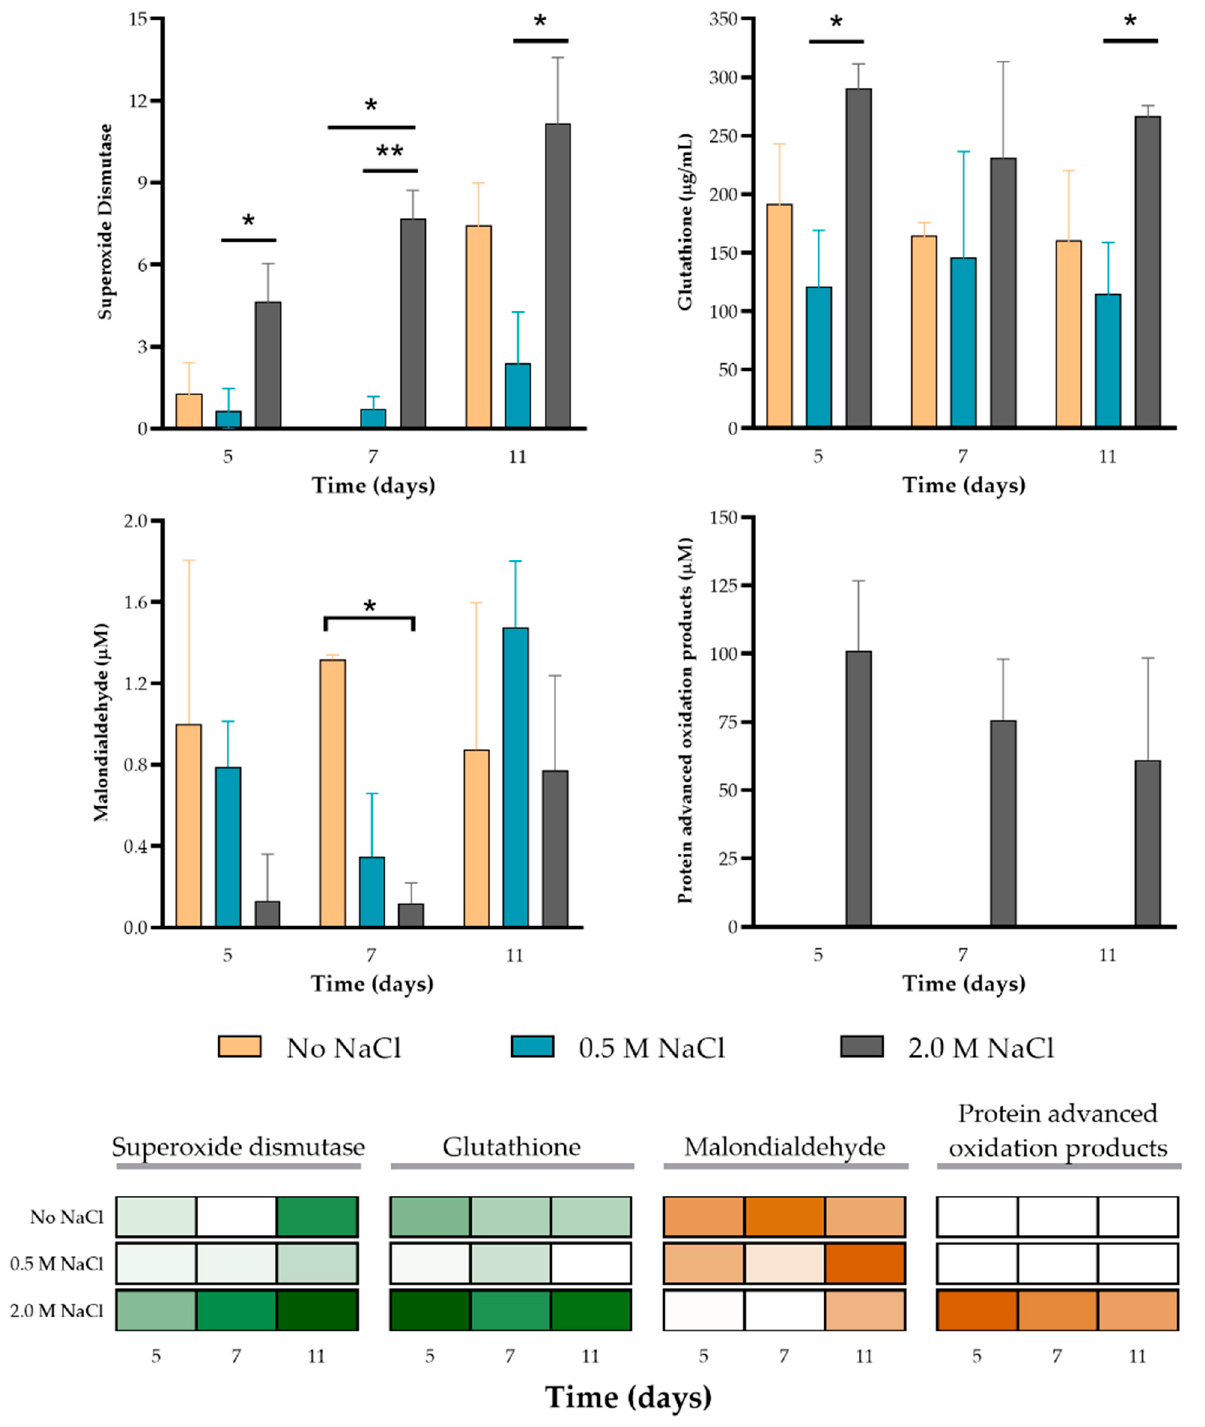
Figure 8. Oxidative stress and antioxidant markers evaluated in A. sydowii cultures under stable salinity conditions. Superoxide dismutase (SOD) and glutathione (GSH) (antioxidants markers; green in the heat maps), malondialdehyde (MDA) and protein advance oxidation products (PAOP) (oxidative damage markers; brown in the heat maps) were analyzed. Data are means ± SD. Bars with the asterisks (*) indicate the significant difference (** p < 0.01, * p < 0.05) between the control and its respective treated samples. Analyzed by a two-way ANOVA with Tukey’s multiple comparisons test.